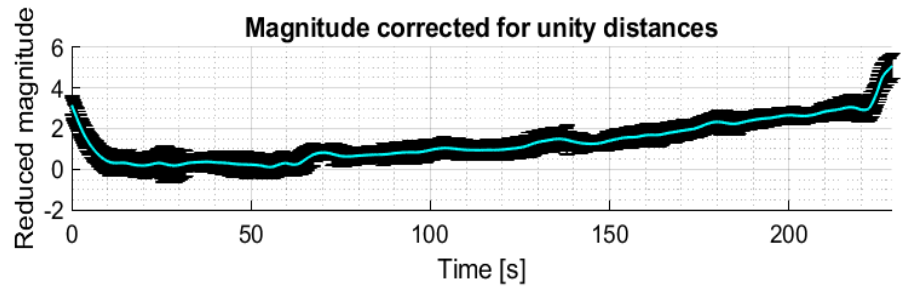
Figure 8. Observed normalized light-curve of CZ-4C (SSN 40879) taken the 22nd of July 2020 from SCUDO observatory.